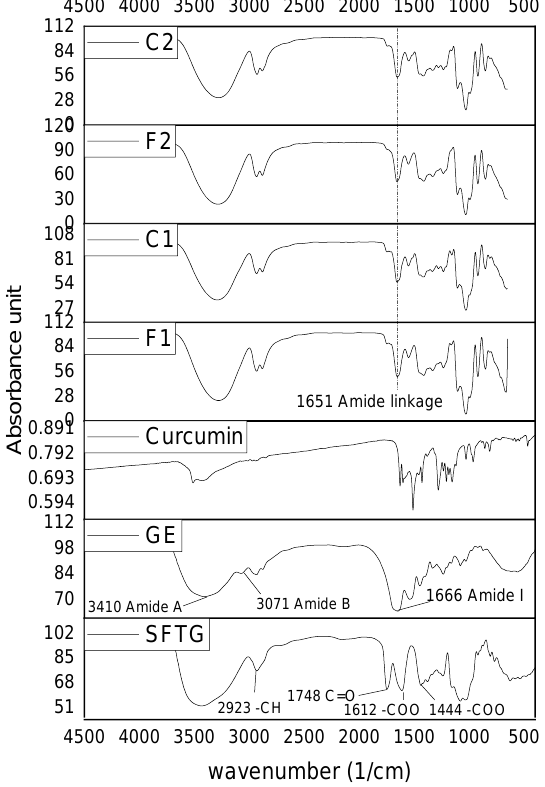
Figure 4. FTIR spectra of curcumin, SFTG, GE, and film samples. F1 (1GE: 1SFTG); F2 (2GE: 1SFTG); C1 (1GE: 1 SFTG/curcumin); C2 (2GE: